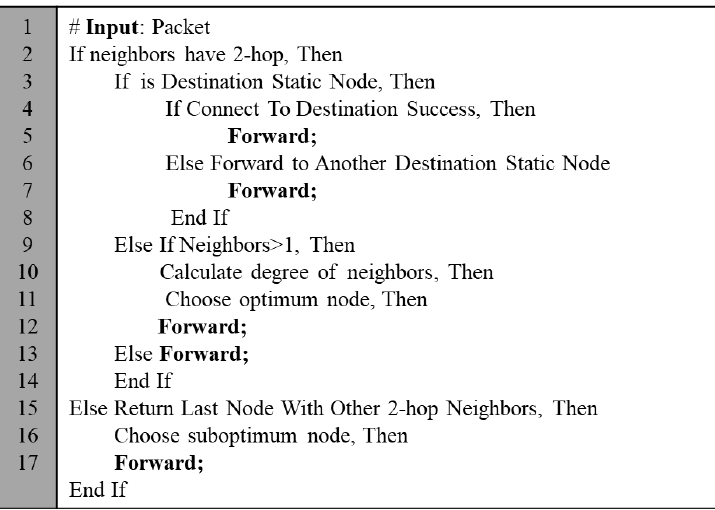
Figure 4. The pseudocode of the intersection decision .